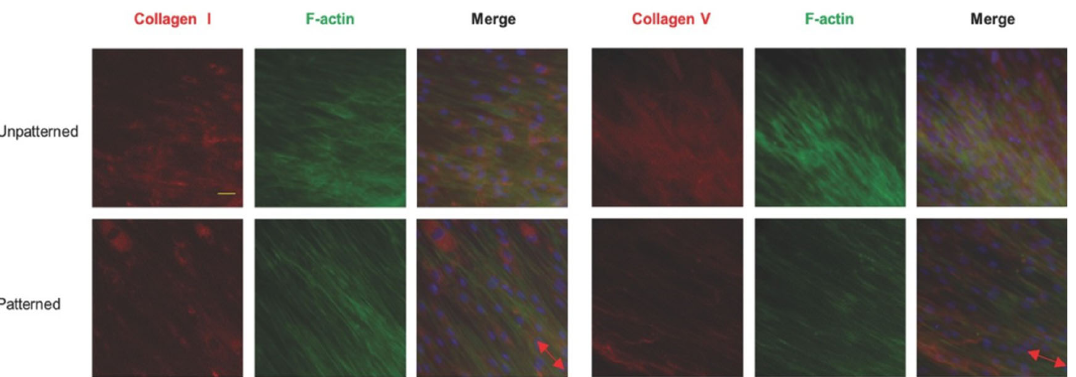
Figure 6. Immunofluorescence staining showed that collagens I and V, the main ECM of the corneal stroma, were well aligned on the patterned silk surface, thus, mimicking the ECM of the native cornea. The red arrows indicate the groove direction of the patterned films. Scale bar = 100 μ m. (Reproduced from [218], Wiley ‐ VCH GmbH, Weinheim).